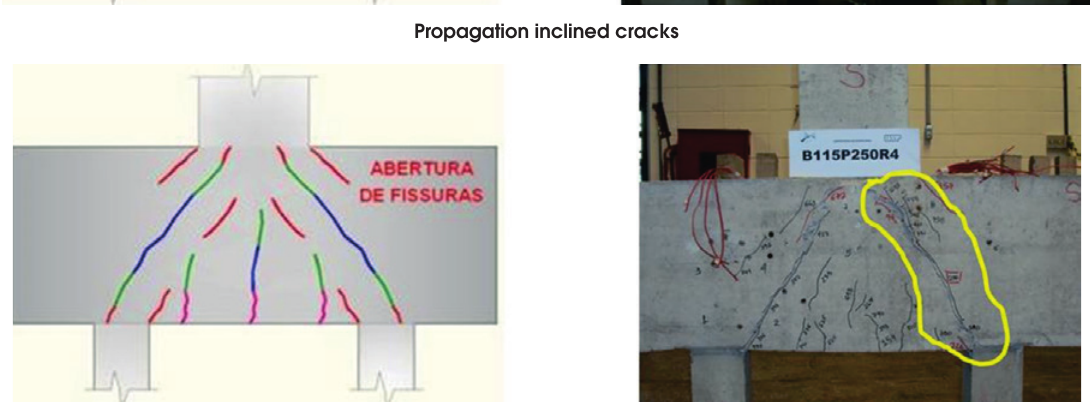
Opening inclined cracks (failure models)